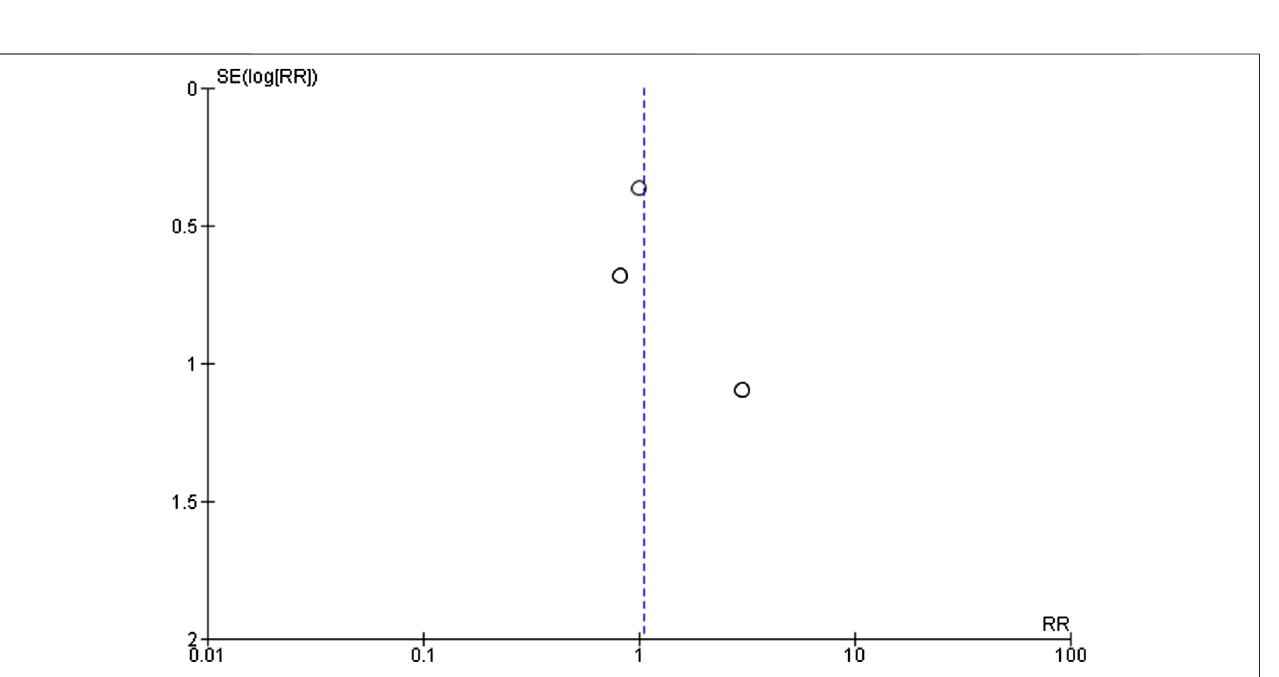
Frontiers in Pharmacology |